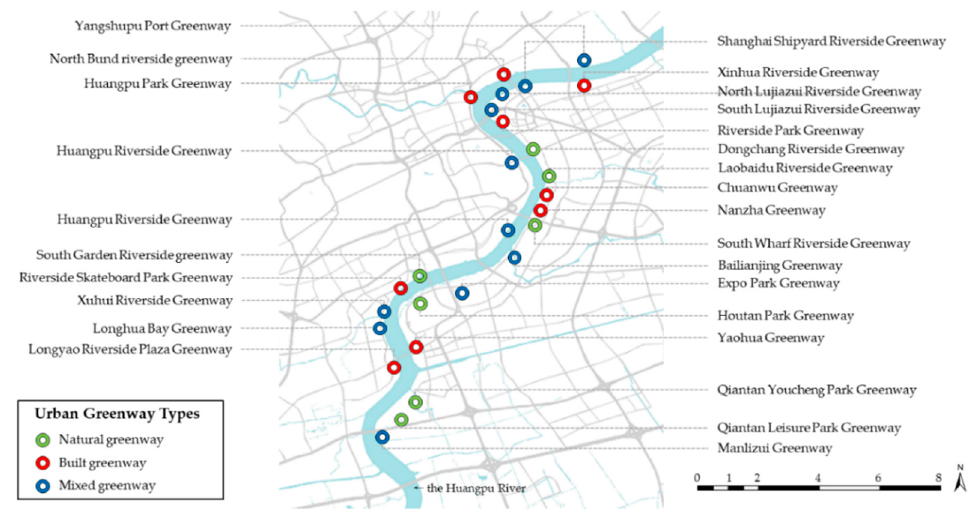
Figure 1. Map of the greenway along the Huangpu River, which is also the site of questionnaire distribution and data collection in this study.